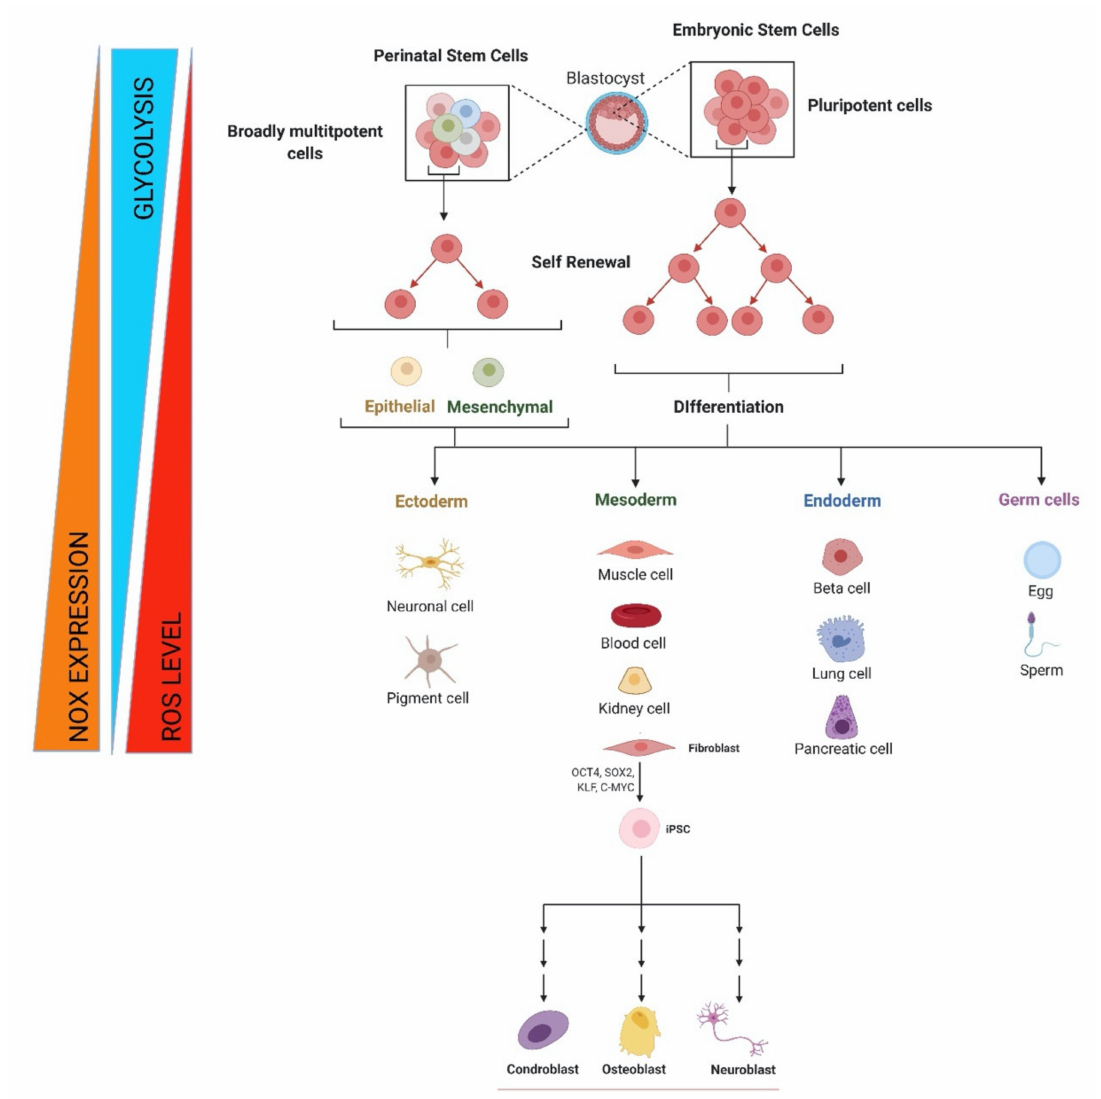
Figure 1. Metabolic and redox changes during stem cell life. Regulation of self-renewal, differentiation, and reprogramming by NOX-derived ROS beside glycolytic metabolism for embryonic, fetal, and adult stem cells. Image created with BioRender. com (accessed on 1 May